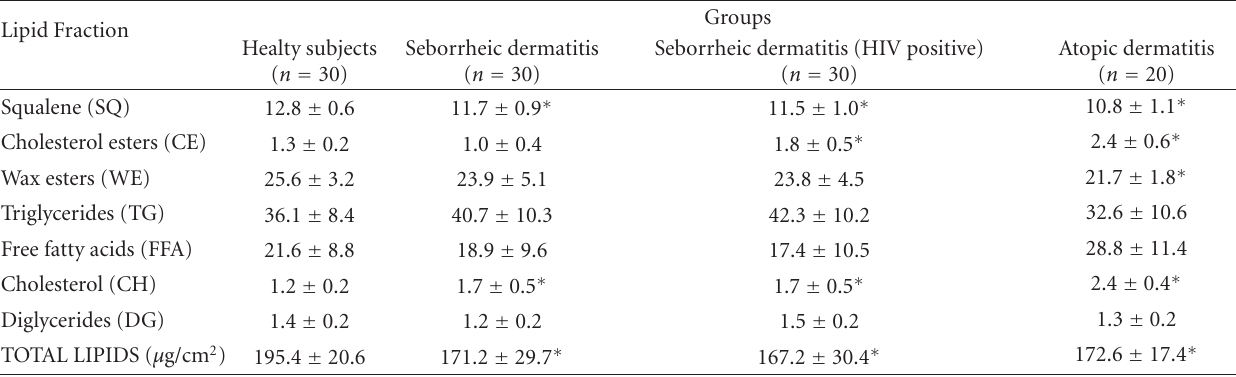
Table 2: The skin surface lipid (SSL) composition (%) and total lipid content in adult healthy subjects and in adult patients su ff ering from seborrheic dermatitis (HIV-negative and HIV-positive) and atopic dermatitis (according to [29, 30]). Groups Lipid Fraction Healty